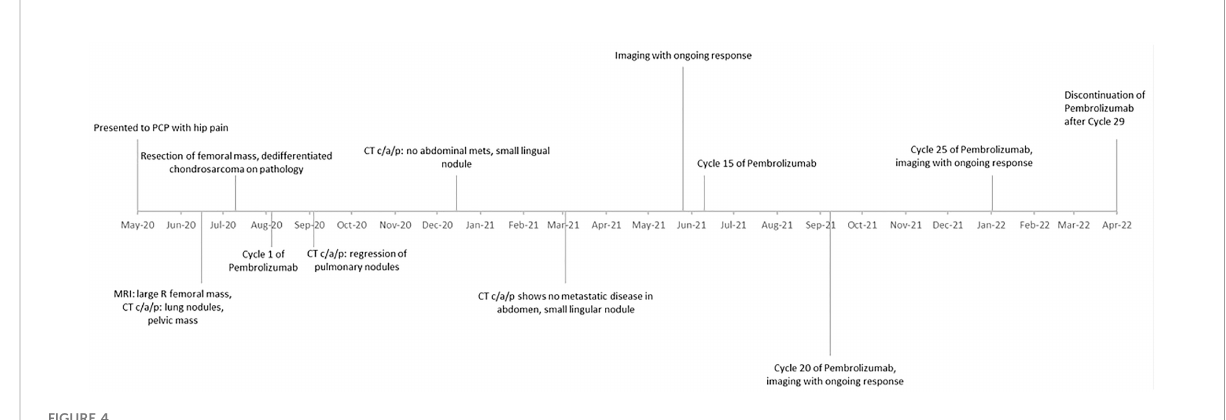
FIGURE 4 Timeline of events from time of presentation to last treatment cycle.